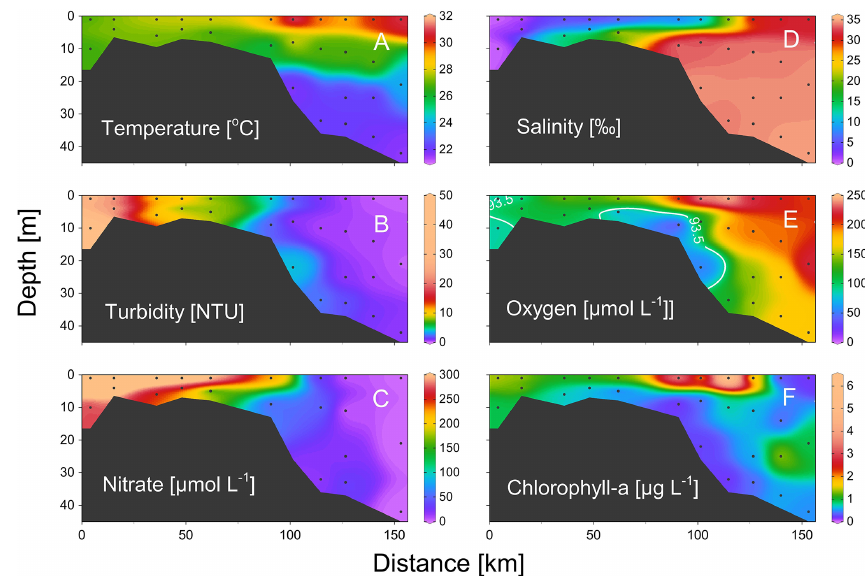
Figure 3. Vertical distributions of (a) temperature, (b) turbidity, (c) nitrate, (d) salinity, (e) dissolved oxygen, and (f) chlorophyll a from the estuary to the shelf of the NSCS during June 2016. Section locations are shown in Fig. 1; the white line in panel (d) shows the area of oxygen-deficiency zone ( < 93.5µmolkg − 1 ).